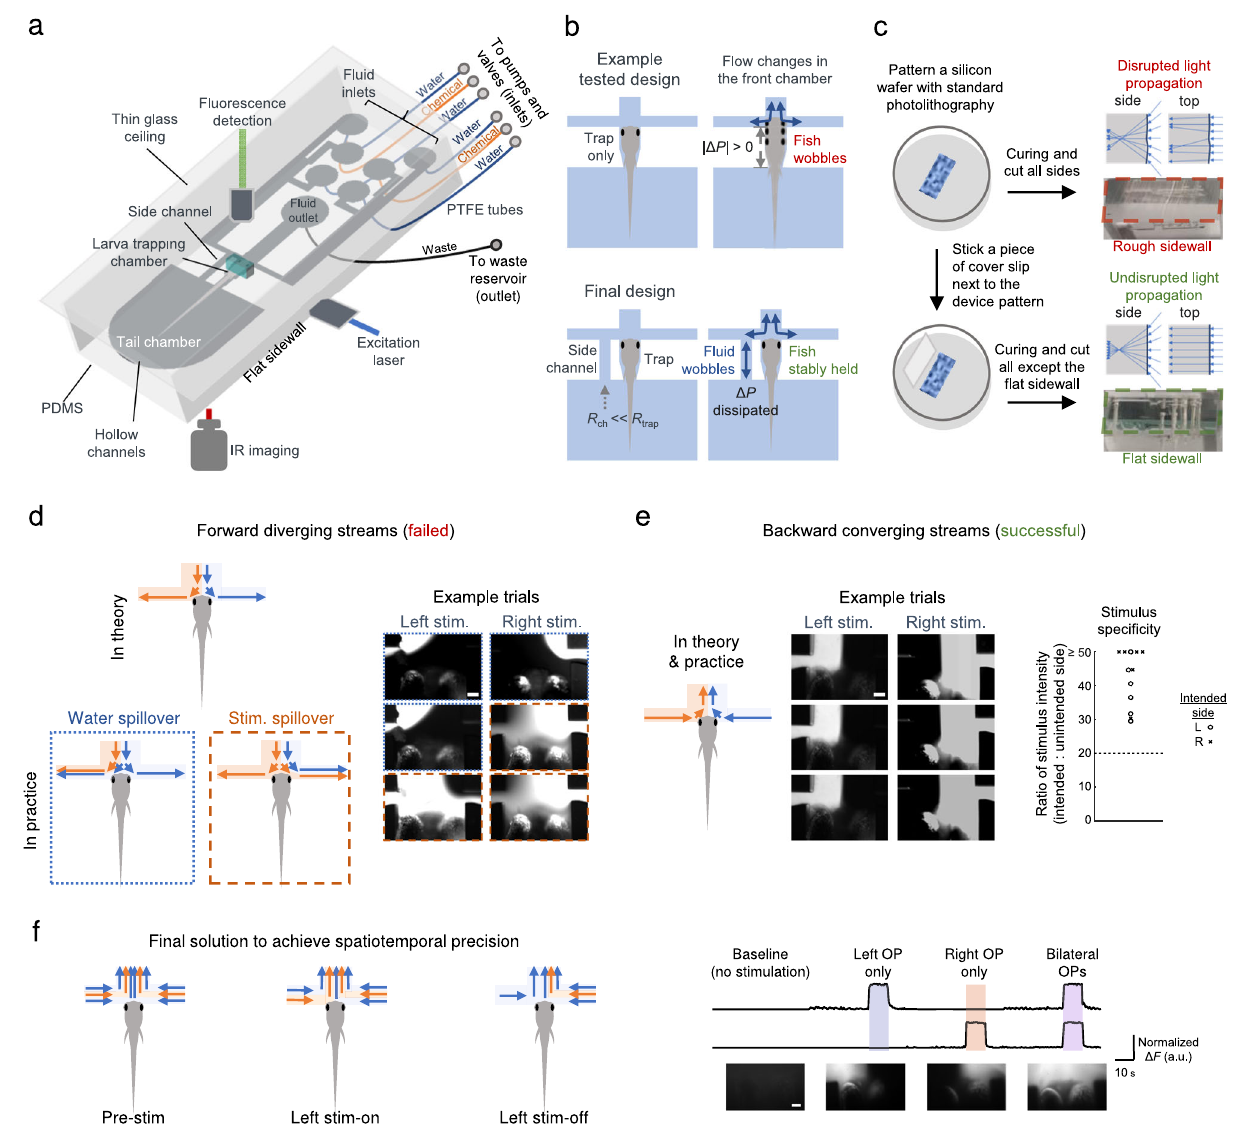
fl ow directions. Right panel: example images showing contralateral spillover of chemical or water (speci fi ed using corresponding image outlines). e Left panel: schematic depictions of the fl uid segregation using backward converging streams (left-side stimulation illustrated). Middle panel: example images. Right panel: the ratio of stimulus intensity (intended side vs. unintended side) in test trials ( n =12 trials in 2 larvae), quanti fi ed with fl uorescent imaging using 100 µ M fl uorescein in the chemical stream. All recorded ratios were >20 (dashed line). Images in d and e were acquired with three trials for each side with a larva. Scale bars in d and e : 100 µ m. f Left panel: the fl uidic streams layout that was implemented during dif- ferent periods of unilateral stimulus delivery (left-side stimulation illustrated). Right panel: visualization and monitoring of nasal stimulation by fl uorescence imaging of 1 µ M fl uorescein in the vicinity of each OPs. Images show one trial for each case with a larva. Scale bar: 100 µ m. Source data are provided as a Source Data fi